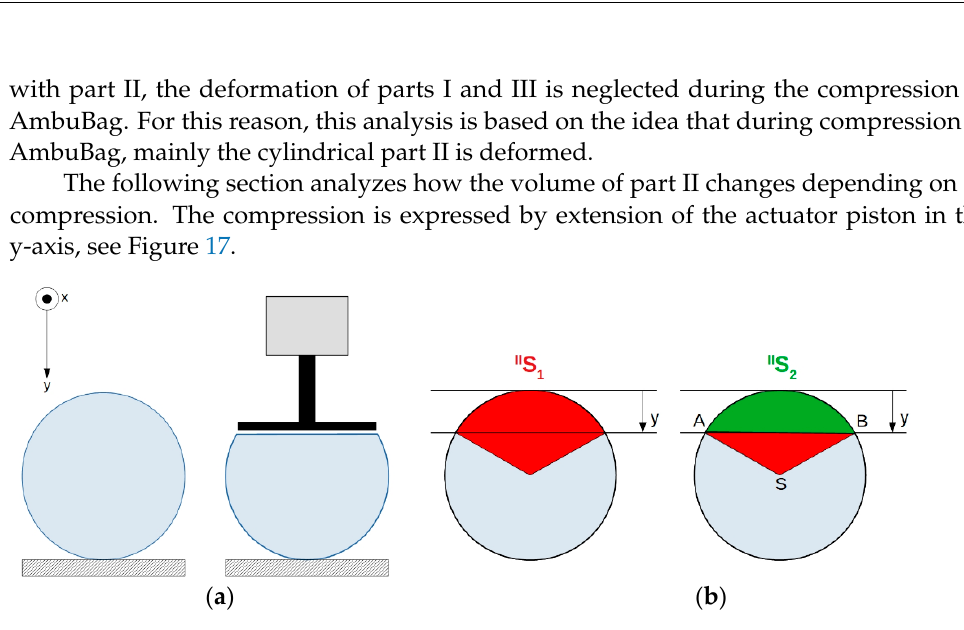
Figure 18. Residual volume in AmbuBag with changing extension of the pneumatic actuator.